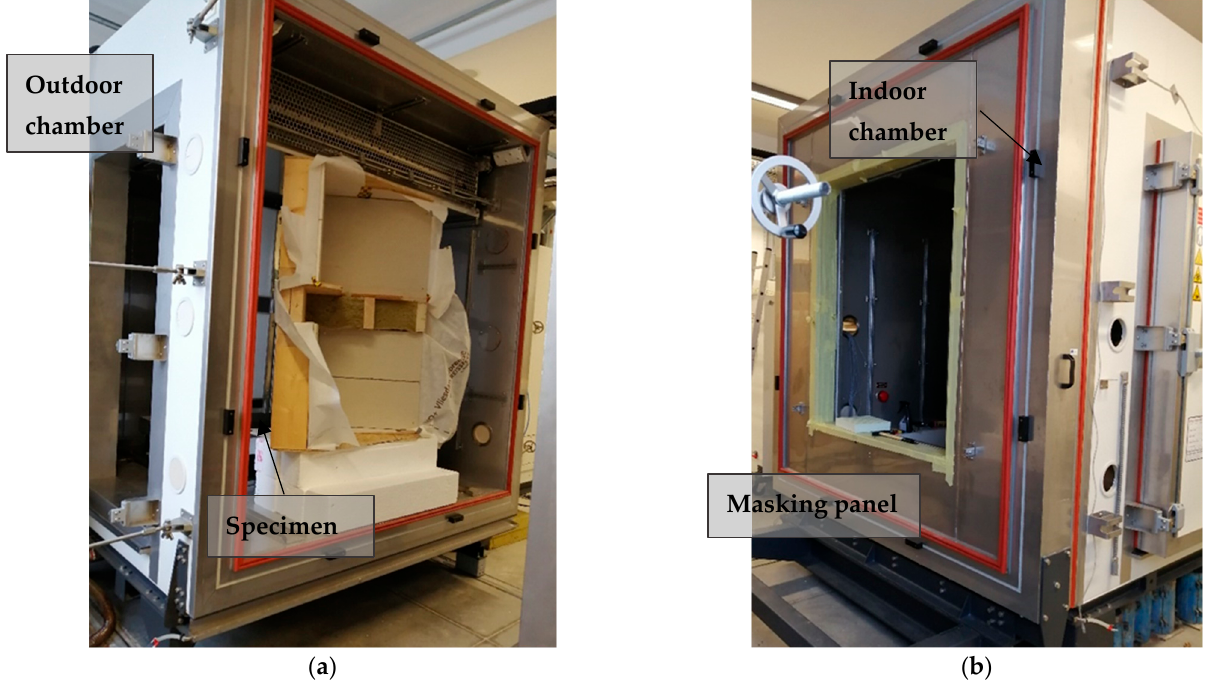
Figure 1. Climatic chambers Weiss Umwelttechnik HmbH, internal dimension 2 × 2 m: ( a ) outdoor chamber with the specimen; ( b ) indoor chamber and a masking panel.